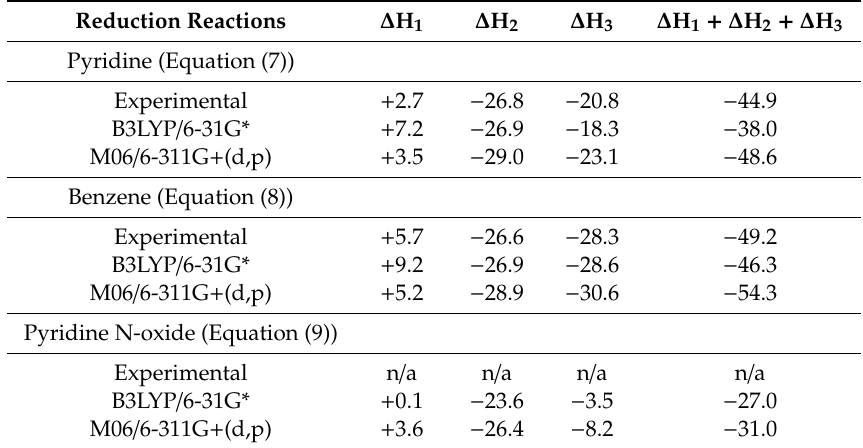
Table 7. Comparisons between experimental and computational reaction enthalpies (kcal/mol) for the hydrogenation reactions depicted in Equations (7)–(9).